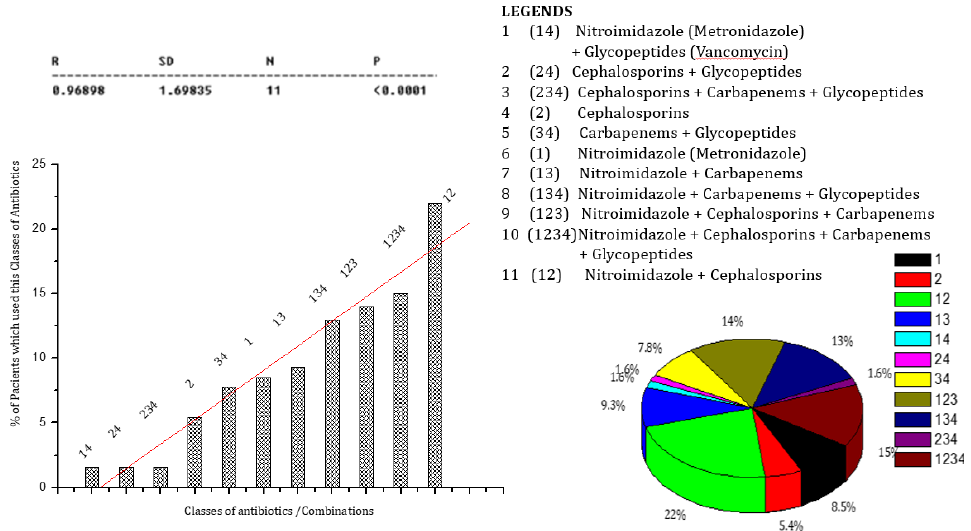
require increasingly complex